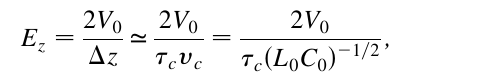
where 2 V is the incremental voltage change of a ramped 0 pulse over an incremental distance (cid:1) z , (cid:1) is the duration of c the ramped pulse, and v , L , and C are the circuit speed, c 0 0 the equivalent inductance, and the equivalent capacitance per unit length of the transmission line, respectively. At the low frequencies involved, the wave propagates with almost no dispersion, so the wave pulse shape is preserved as it progresses downstream; that is, the voltage profile V (cid:4) z (cid:1) v t (cid:5) changes only slightly with time. Figure 1(a) is a c schematic representation of a helical pulse line structure.